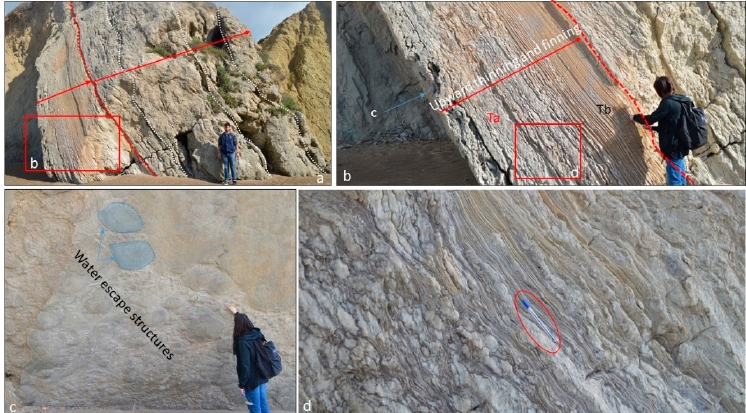
Figure 9. ( a ) The upper part of turbiditic evaporites between shales. See amalgamation surfaces internally to the evaporites, marked with white dashed lines. Red line shows the contact between two cycles. ( b ) The lower part of the above evaporitic horizon with characteristic fining and thinning upward trend. Blue arrow shows the base of these evaporites. ( c ) Water-escaped structures clearly showed at the base of the above evaporitic horizon. ( d ) Strong deformation within this lower cycle of the evaporitic turbidites.